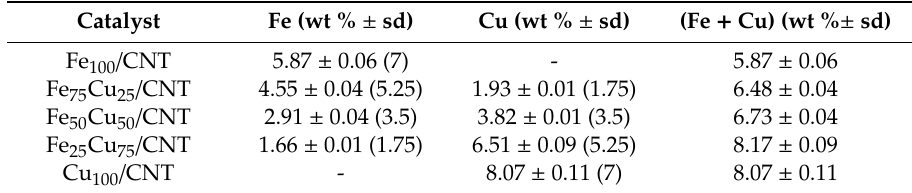
Table 2. Content of metal (wt %) of Fe (100 − x) Cu x / CNT determined by inductively coupled plasma optical emission spectrometry (ICP-OES) *.